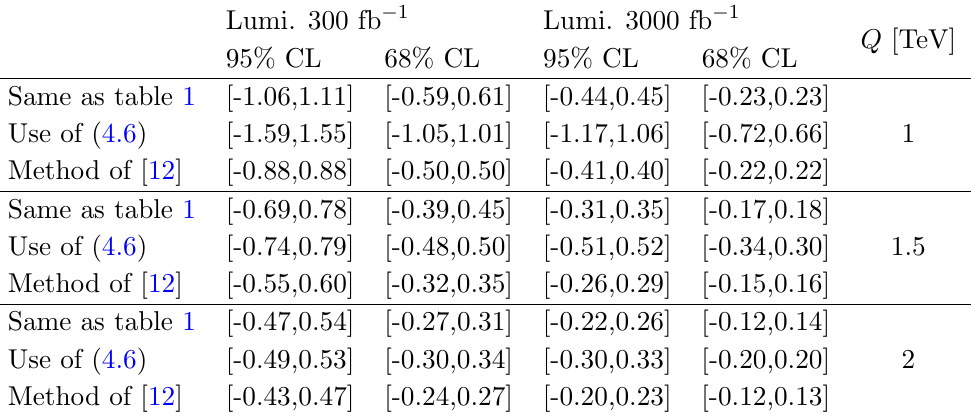
Table 2 . Comparison of di(cid:11)erent methods. Table 1 and (cid:12)gure 6 are our main (cid:12)nal results. We (cid:12)nd that LHC at 3ab (cid:0) 1 (300fb (cid:0) 1